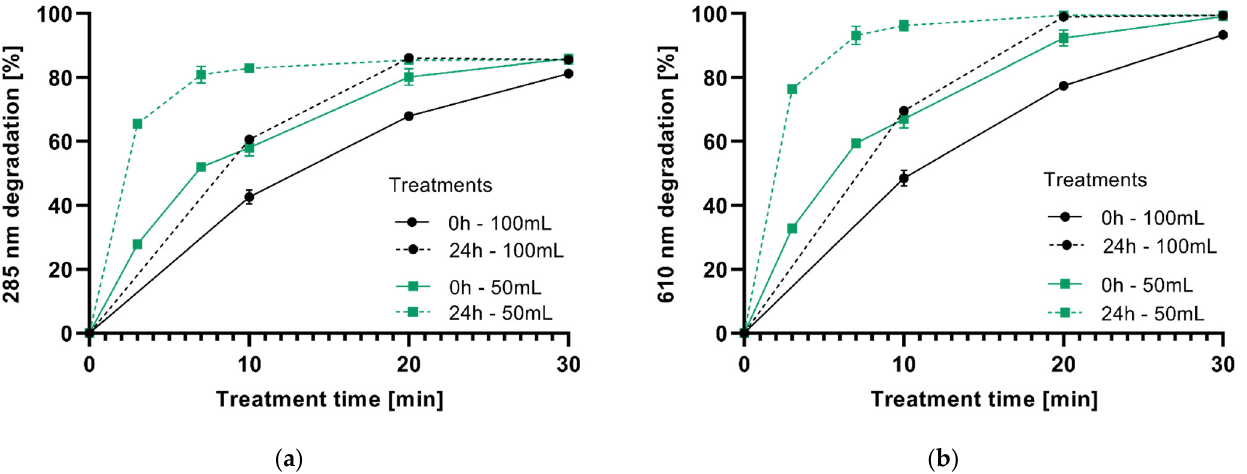
Figure 6. IC degradation immediately after discharge (0 h) and after 24 h of storage (24 h), as a function of treatment time (0–30 min), for two volumes of water (50 and 100 mL) at 285 nm ( a ) and 610 nm ( b ).